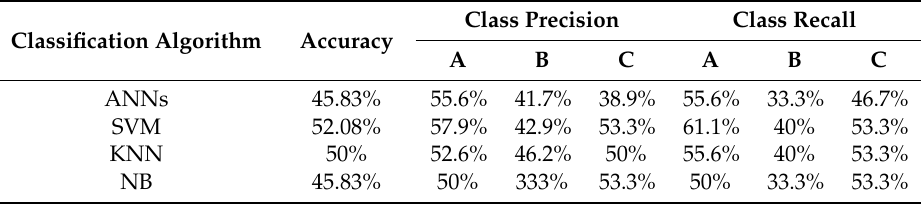
Table 3. Results of classification with numeric data only.